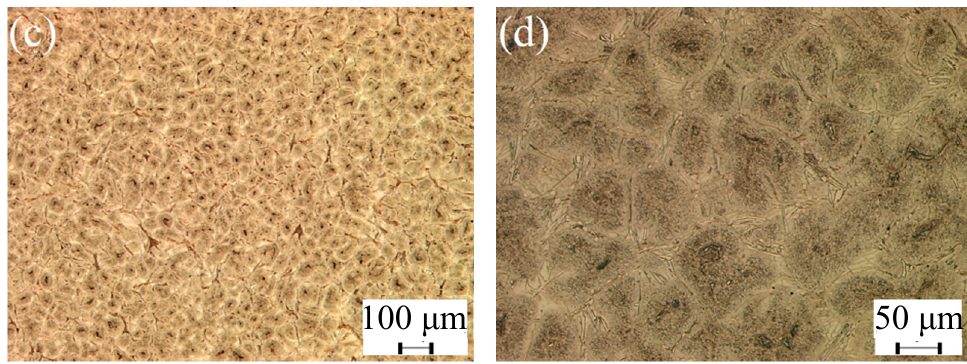
Figure 2. OM images of HSS solidification structure: ( a , b ) As-cast ingot; ( c , d ) ESR ingot.